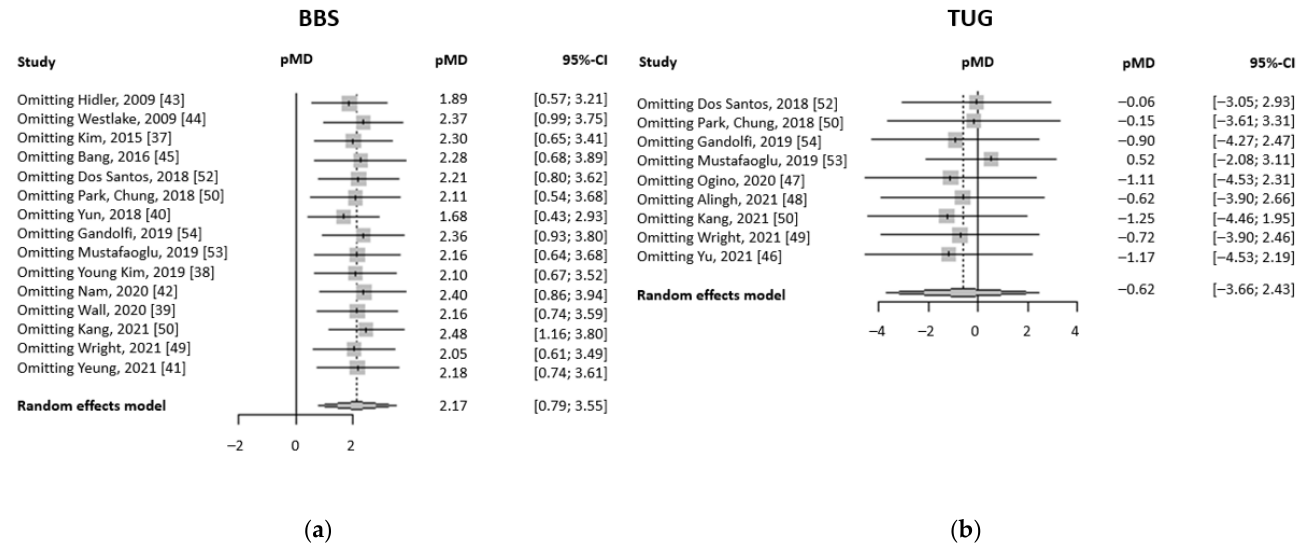
Figure 4. Forest plots summarizing the influence analyses performed: ( a ) pMD obtained omitting one study at a time (on the left) in BBS meta-analyses; ( b ) pMD obtained omitting one study at a time (on the left) in TUG meta-analyses.